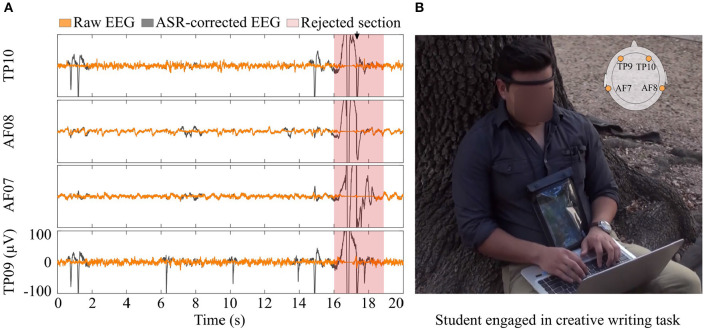
Equipment setup and EEG data pre-processing. (A) Raw (black) and pre-processed (orange) EEG data. Shaded areas indicate rejected intervals. (B) A student wearing the EEG headset during the Generation stage.